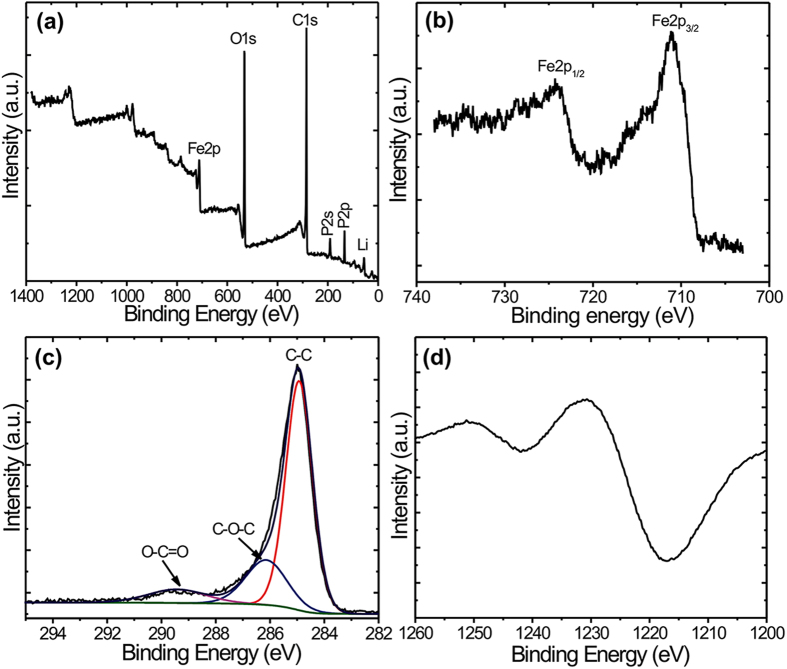
XPS spectra of the LiFePO4/C powder calcined at 700 °C (a) Full spectrum of LiFePO4/C (b) narrow spectrum of Fe2p (c) core-level XPS spectrum of C1s and (d) Derivate of the carbon auger peak.